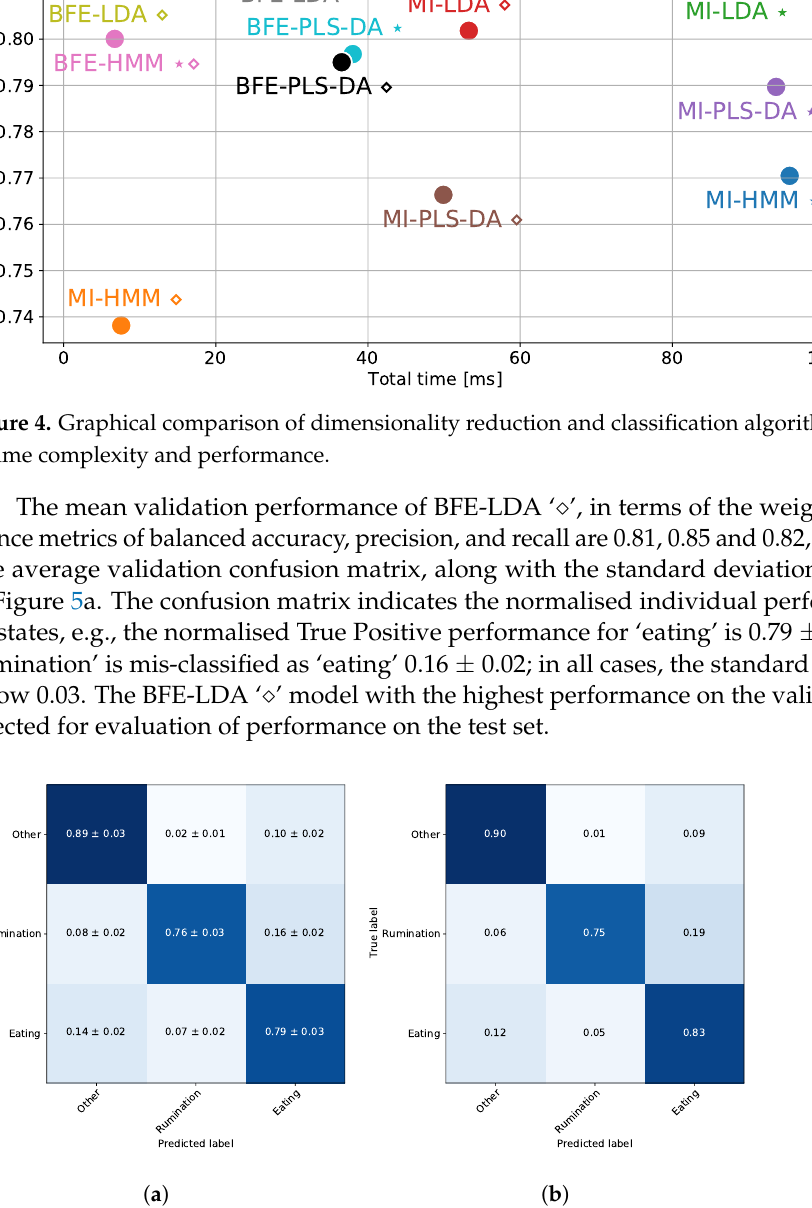
Figure 5. Confusion matrices for the selected classification model based on a LDA utilising features selected through BFE that yielded the best trade-off between model performance and complexity— BFE-LDA ‘ (cid:5) ’. ( a ) Validation dataset. ( b ) Test